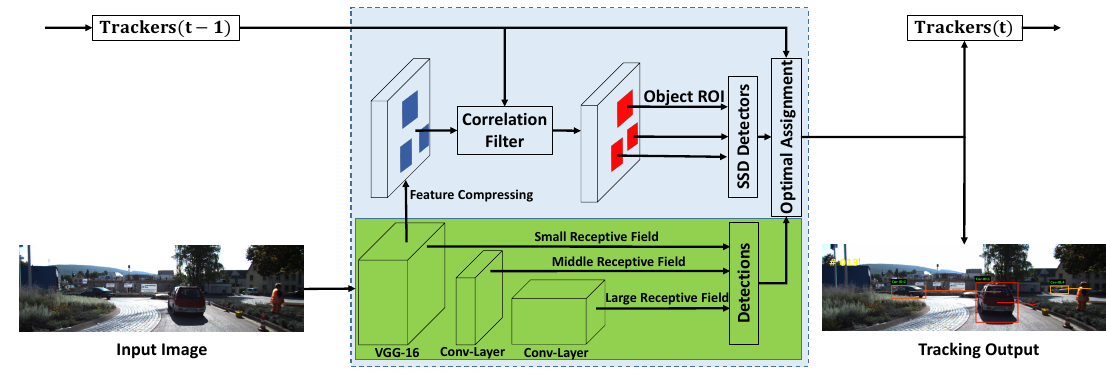
Figure 1. The framework of the proposed